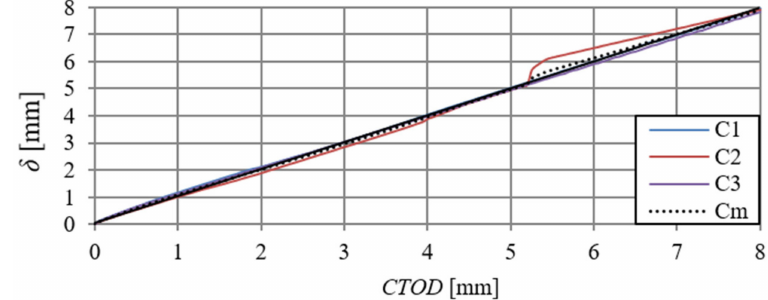
Figure 13. Deflection–crack tip opening displacement relationships of C-series beams and the relationship δ –CTOD obtained on the basis of the arithmetic mean of results